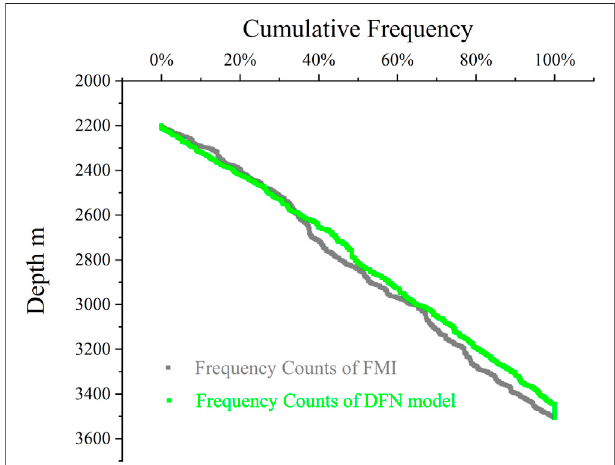
FIGURE 3 | Cumulative density distribution of the measured and simulated fractures in well